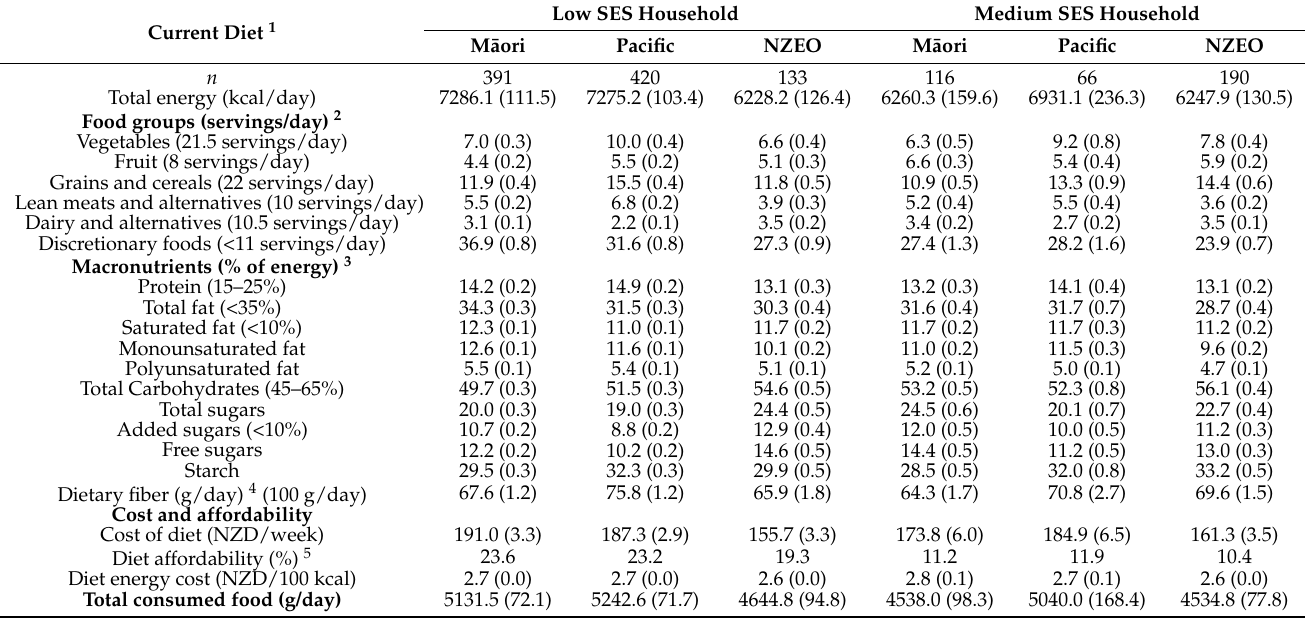
Table 3. The current NZ diet for each reference household, by ethnicity and